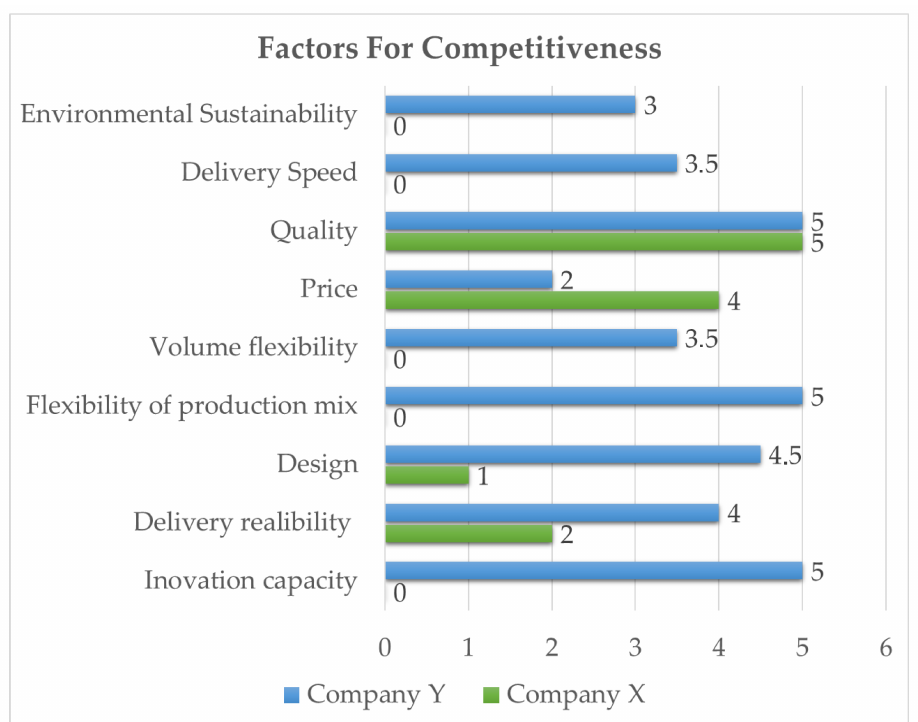
Figure 2. Factors for competitiveness.